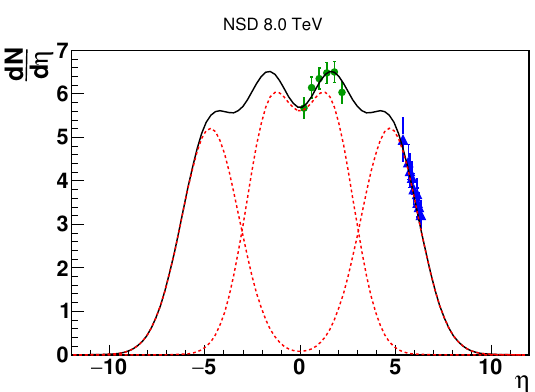
√ s = 8 TeV [11] de- Figure 2. Central pseudorapidity density dependence on s for E 0 = 10 13 -10 17 eV (solid line for NSD component, dashed line with diamonds devoted to the inelastic component is aproxi- matelly 0.8695 · ρ (0)